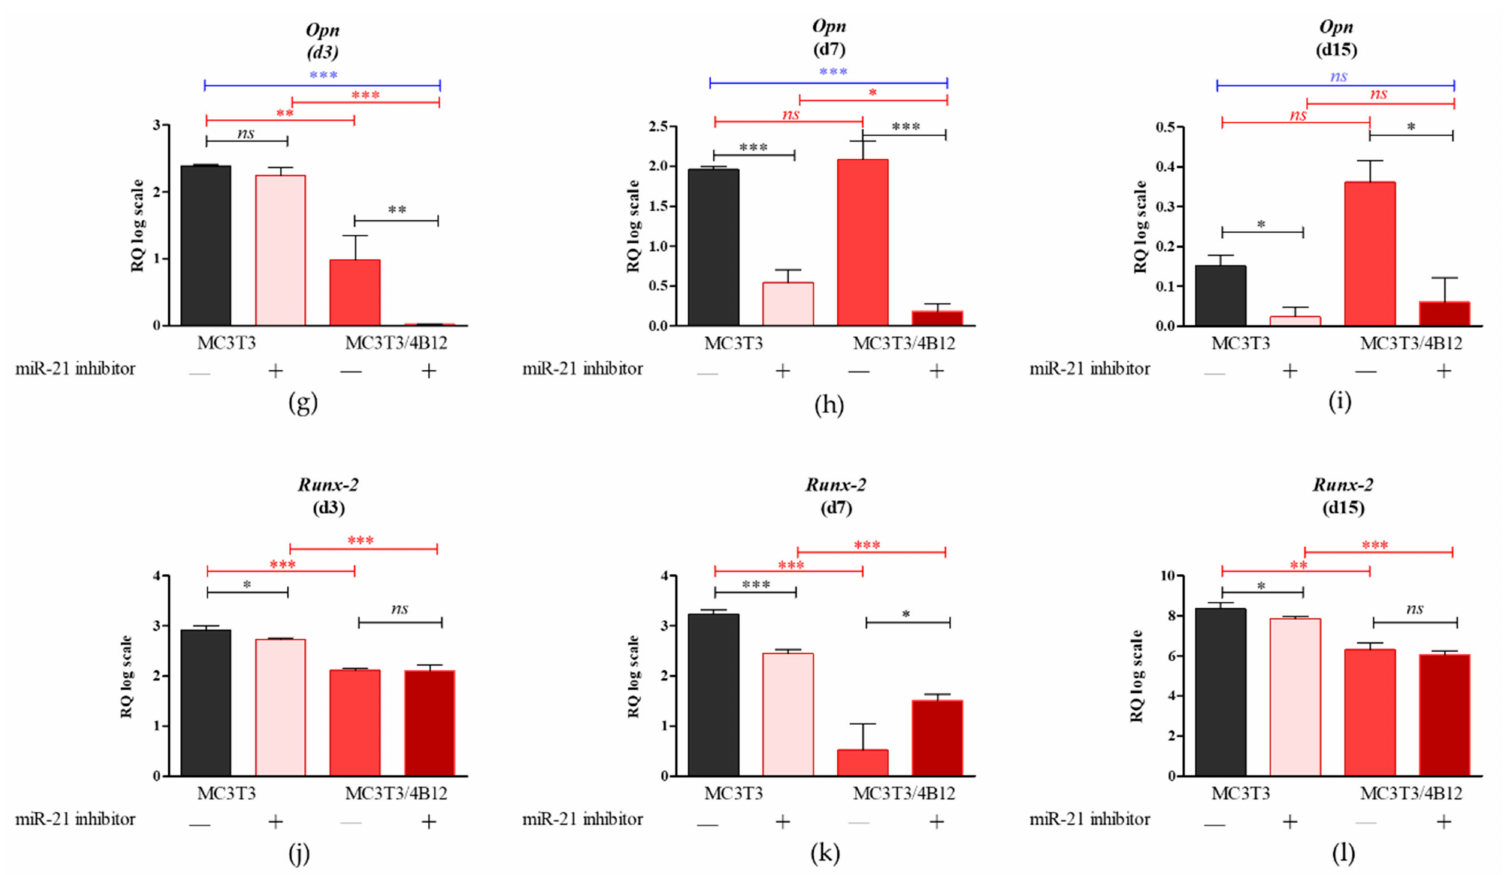
Figure 1. The results of RT-qPCR analysis showing the mRNA levels of key osteogenic markers measured after 3 ( a , d , g , j ), 7 ( b , e , h , k ), and 15 days ( c , f , i , l ) of osteogenic cultures (d3 d7 and d15 respectively). Following osteogenic markers were determined: osteocalcin ( Ocl ) ( a – c ), collagen type I ( Coll-1 ) ( d – f ), osteopontin ( Opn ) ( g – i ) and runt-related transcription factor 2 ( Runx2 ) ( j – l ). Significant di ff erences are indicated with asterisks (* p < 0.05; ** p < 0.01 and *** p < 0.001), while non-significant di ff erences are marked as ns . The comparisons between groups are marked with square